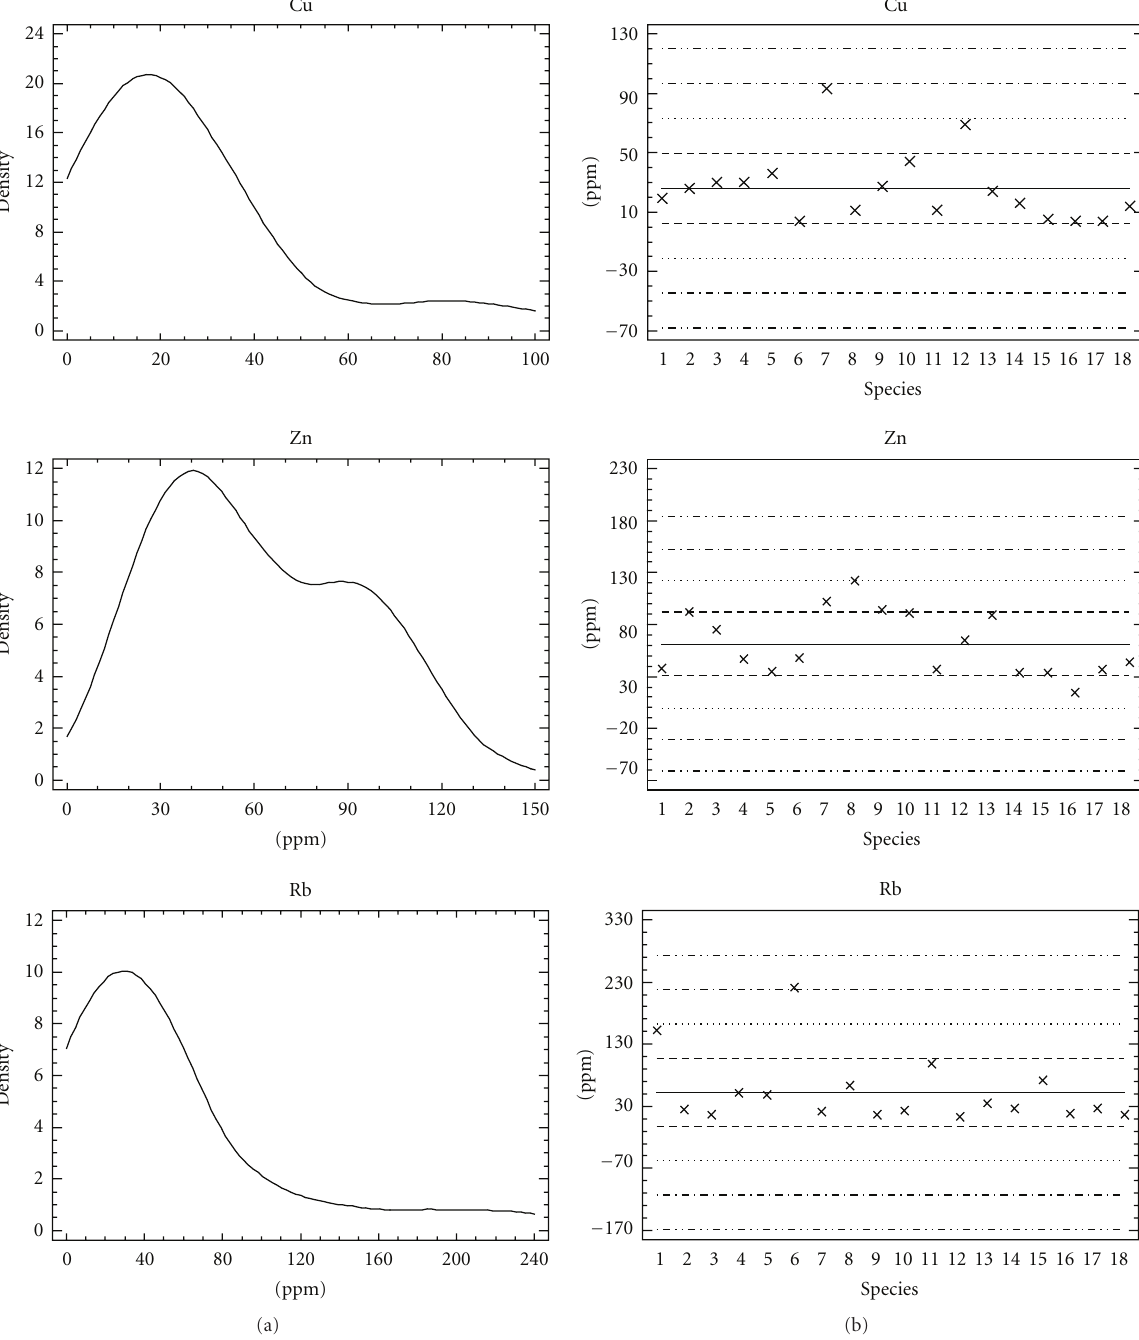
the standards provided for calibration by the manufacturer and the samples to be analyzed were homogenized and pressed in the same way so that all the (cylindrical) samples had the same physical characteristics. Also, for each sample measurement, the calcination percentage of each species, determined previously, was taken into